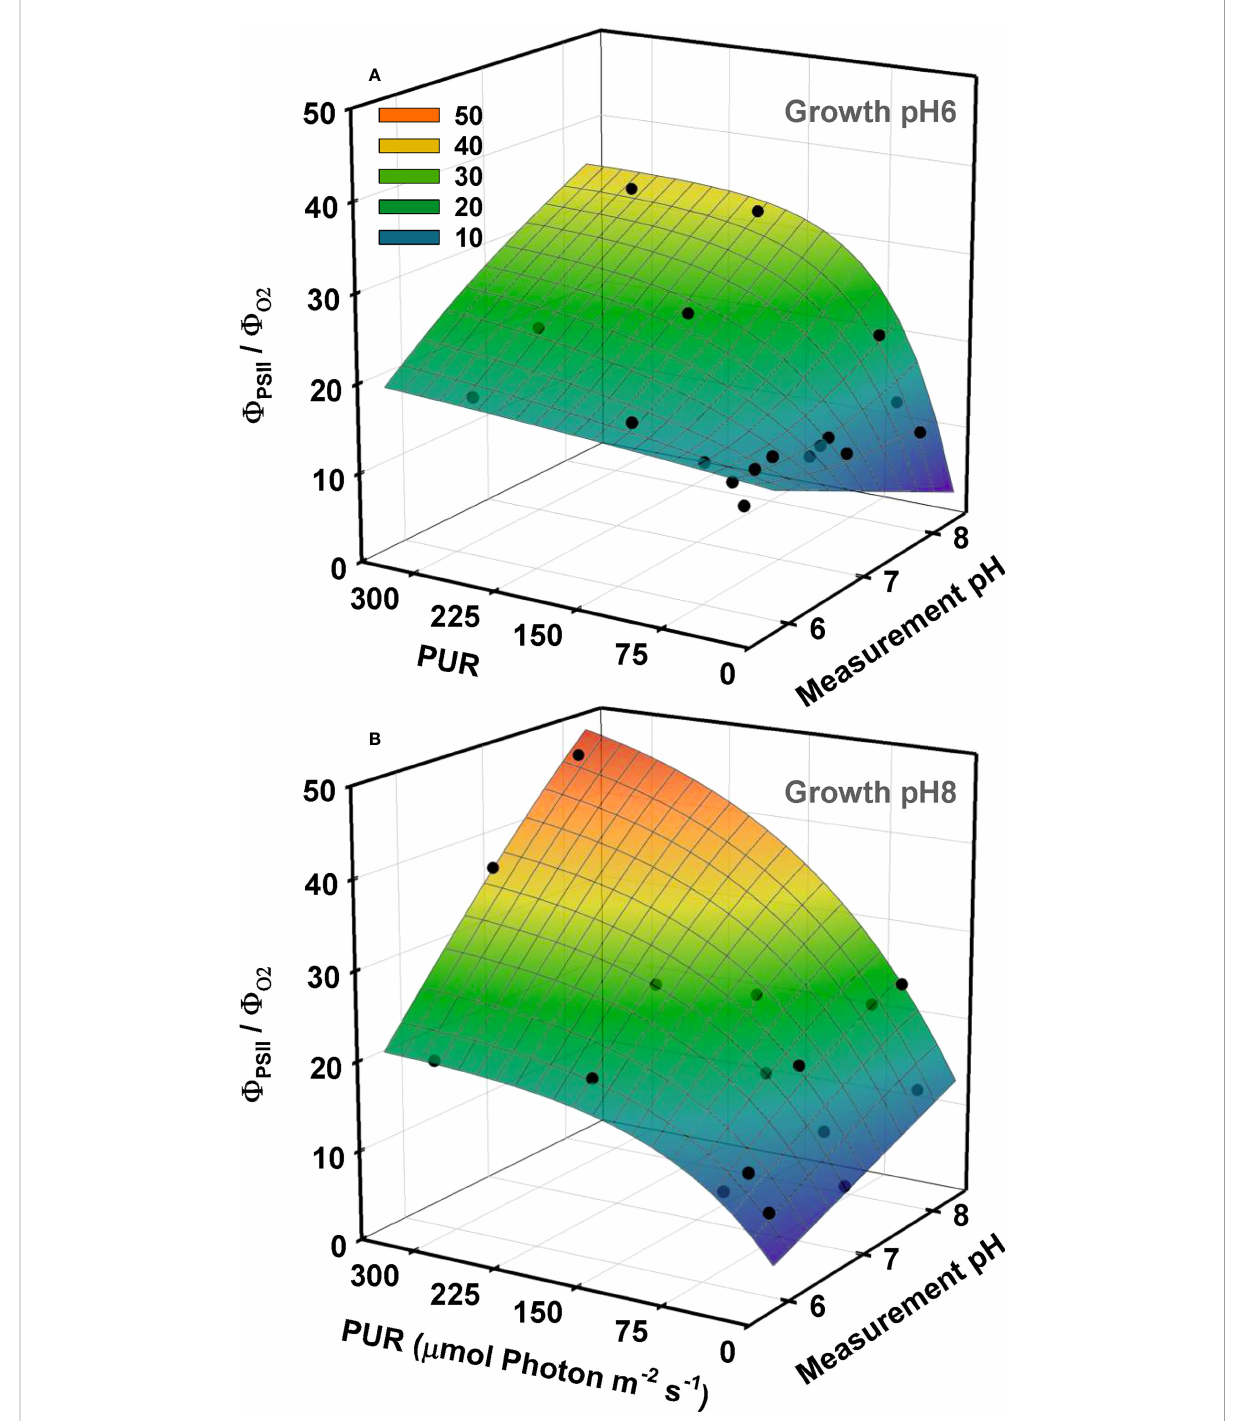
FIGURE 7 Ratio of the quantum yield of fl uorescence ( Ф PSII ) to the quantum yield of oxygen ( Ф O2 ) as a function of light and incubation pH/CO 2 . O 2 production and fl uorescence were measured simultaneously at different pH levels using eelgrass leaves grown at different CO 2 treatments. Yields were calculated using PUR. Growth speci fi c 3D relationships, at pH6 (2121 µ M CO 2(aq) ) (A) and ambient pH8 (55 µ M CO 2(aq) ) (B) , were generated by the combination of non-linear and linear regression fi ts. First, the Ф PSII / Ф O2 ratio as a function of PUR were described by the exponential rise to maximum models separately for each incubation pH/CO 2 . Parameter estimates of these non-linear regression models were fi tted as a function of incubation pH using linear